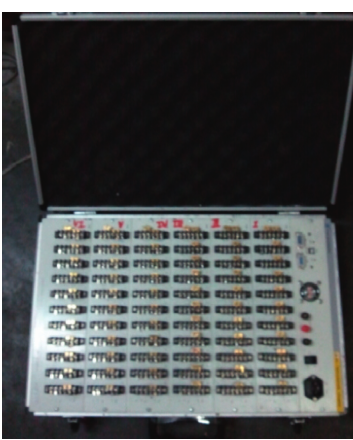
Figure 6: Static strain